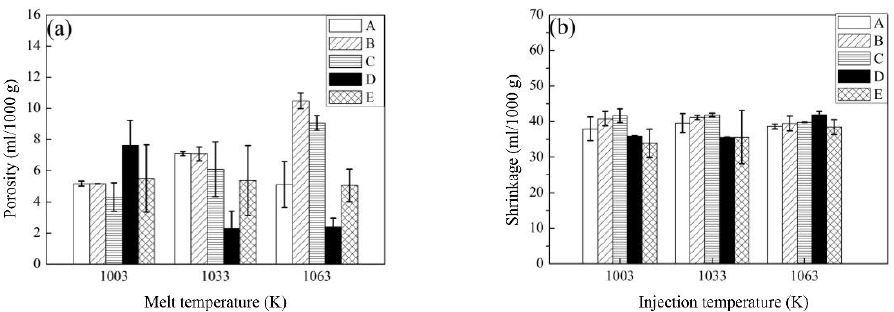
Figure 6. Porosities and shrinkage volumes of alloys A, B, C, D, and E were measured by the Tatur